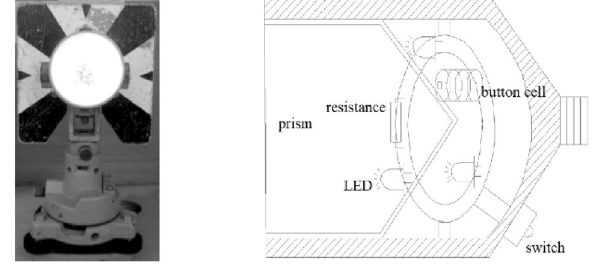
Figure 8. Prism with white LED.